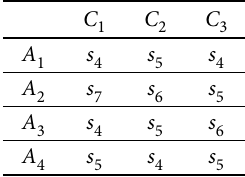
Table 2. Linguistic decision matrix X 2